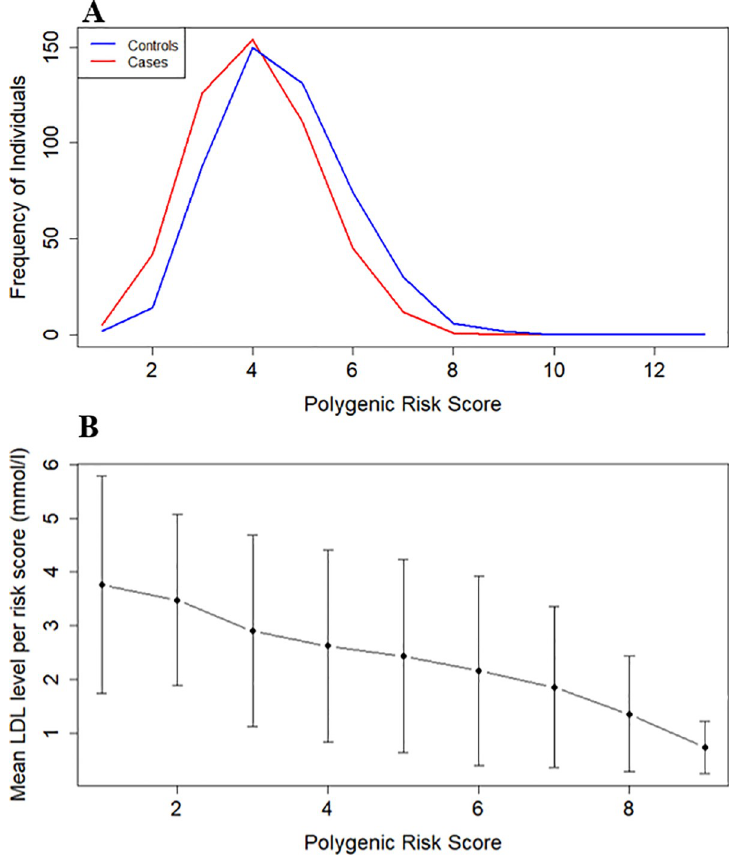
Fig 3. Correlation of the polygenic risk score (PRS) with LDL-cholesterol levels in 993 individuals. Six LDL- cholesterol associated variants (P < 0.05) after adjustment for covariates. Cases include individuals with high LDL- cholesterol levels, and controls with low LDL-cholesterol levels. A: PRS calculated using six variants. Risk score refers to the number of lipid lowering alleles. Plot shows the frequency of cases and controls for each score. The curve of the controls is shifted to the right, indicating that in controls the LDL-cholesterol levels decreases with the addition of alleles associated with lower LDL-cholesterol levels (either common or minor allele). B: Plot of risk score against mean LDL-cholesterol level per risk score. It is apparent that with the addition of each allele associated with lower LDL- cholesterol levels (common or minor allele), the mean LDL-cholesterol level of the participants decreased.